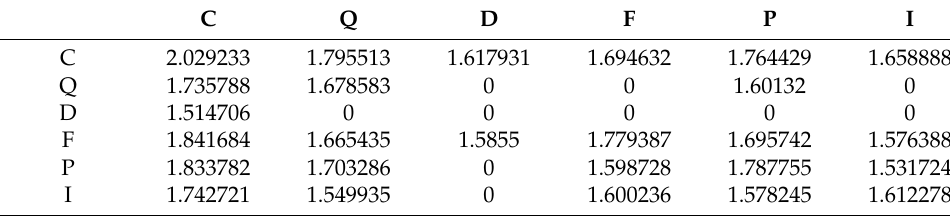
Table 6. The impact relation among factors.